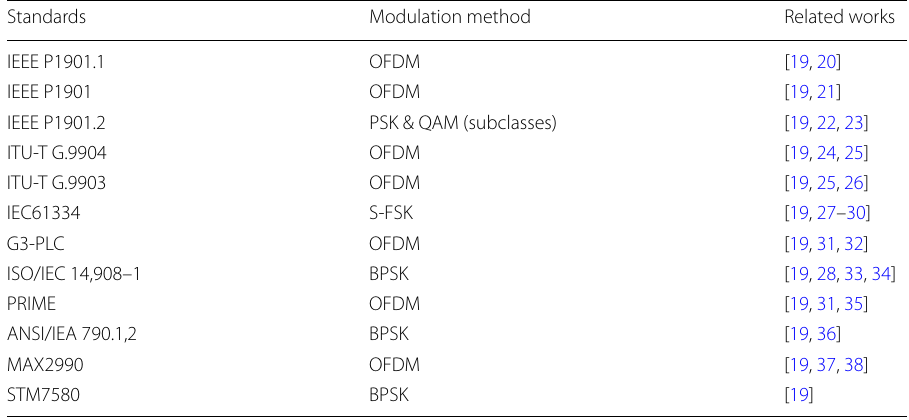
Table 2 Regulator standards for narrowband PLC and relevant modulation methods Standards